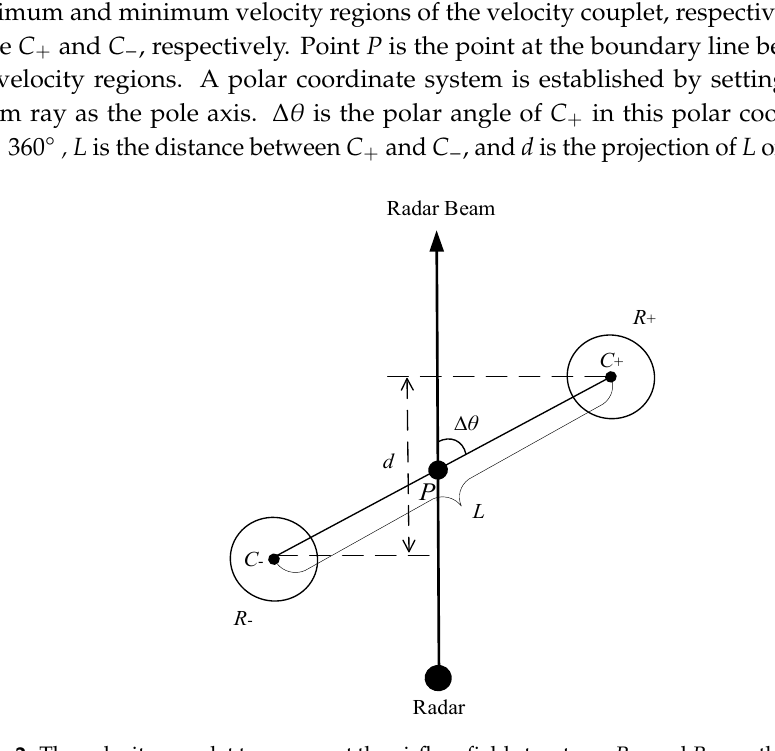
Figure 2. The velocity couplet to represent the airflow field structure. R + and R − are the local maximum and minimum velocity regions of the velocity couplet, respectively. Their geometric centers are C + and C − , respectively. Point P is the point at the boundary line between positive and negative velocity regions. A polar coordinate system is established by setting P as the pole and radar beam ray as the pole axis. ∆ θ is the polar angle of C + in this polar coordinate system and 0 ◦ ≤ ∆ θ < 360 ◦ , L is the distance between C + and C − , and d is the projection of L on the radar beam ray.